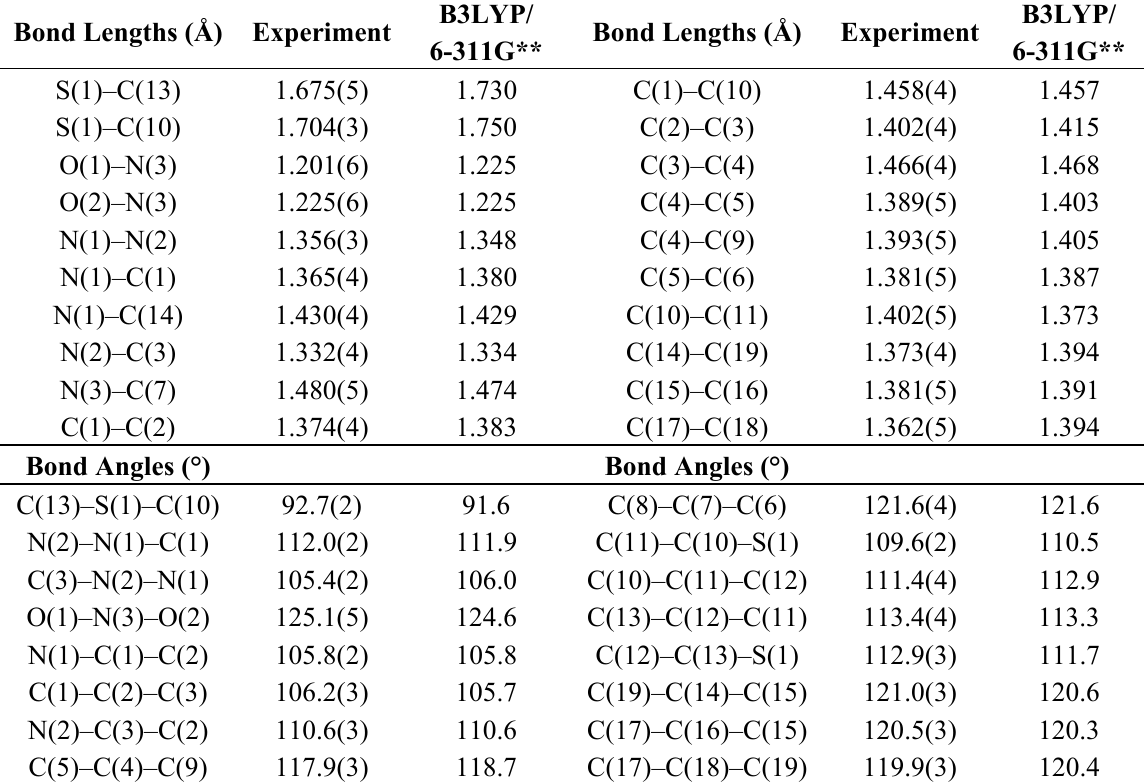
Table 1. Selected structural parameters by X-ray and theoretical calculations.